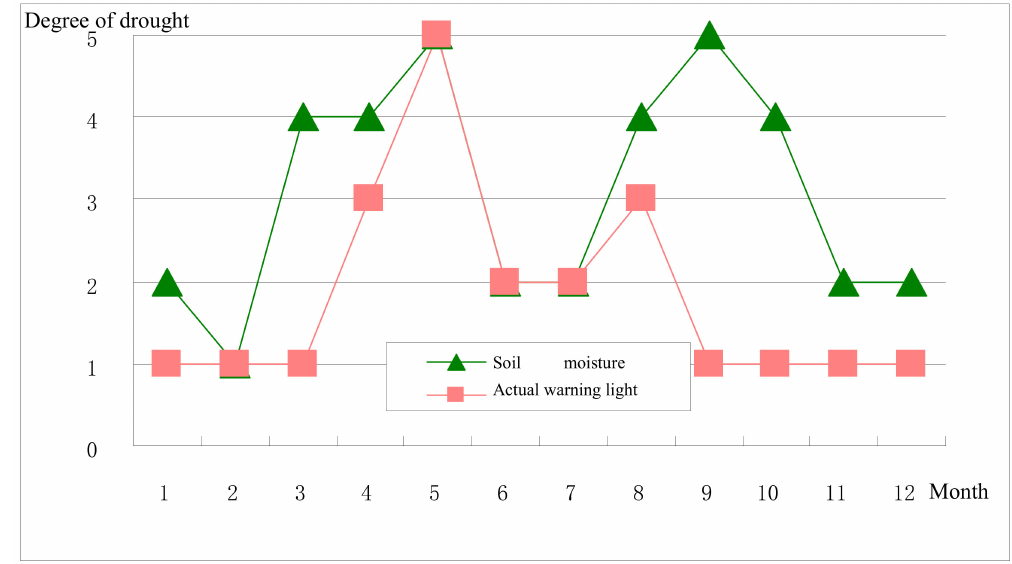
Figure 5. Monthly soil moisture drought degrees and actual early warning signals in